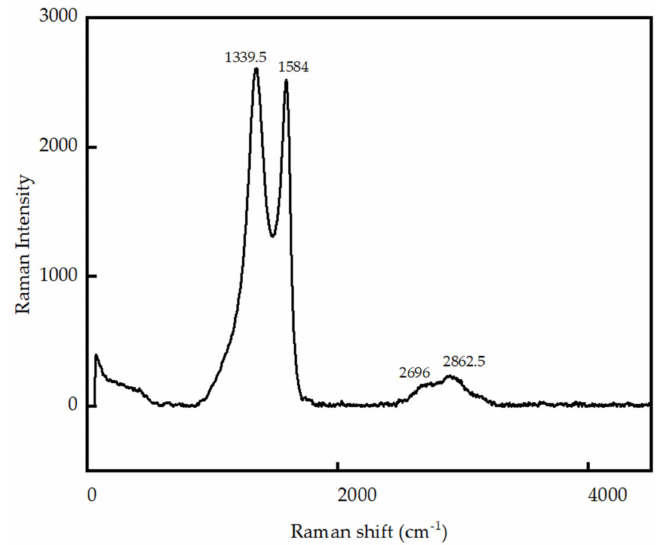
Figure 2. Raman spectroscopy of Graphene Oxide. The intensity ratio (ID/IG) measures the structural disorder of carbon-based materials. The ID/IG ratio of the synthesized GO was found to be 1.034, revealing that almost equal sp3 and sp2 carbon rings are present in GO. The 2D band indicates graphene oxide layer thickness, and the wide 2D band demonstrates that the GO is stacked, increasing its thickness